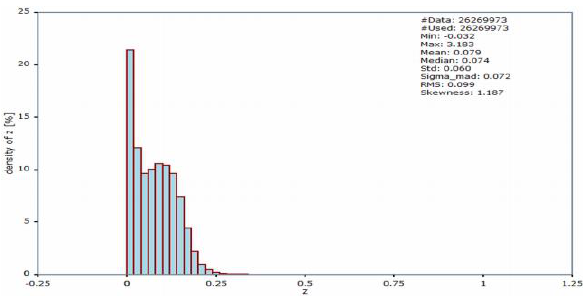
Figure 3. Histogram of the calibrated radiometric reflectance values displayed in the lower part of figure 2.